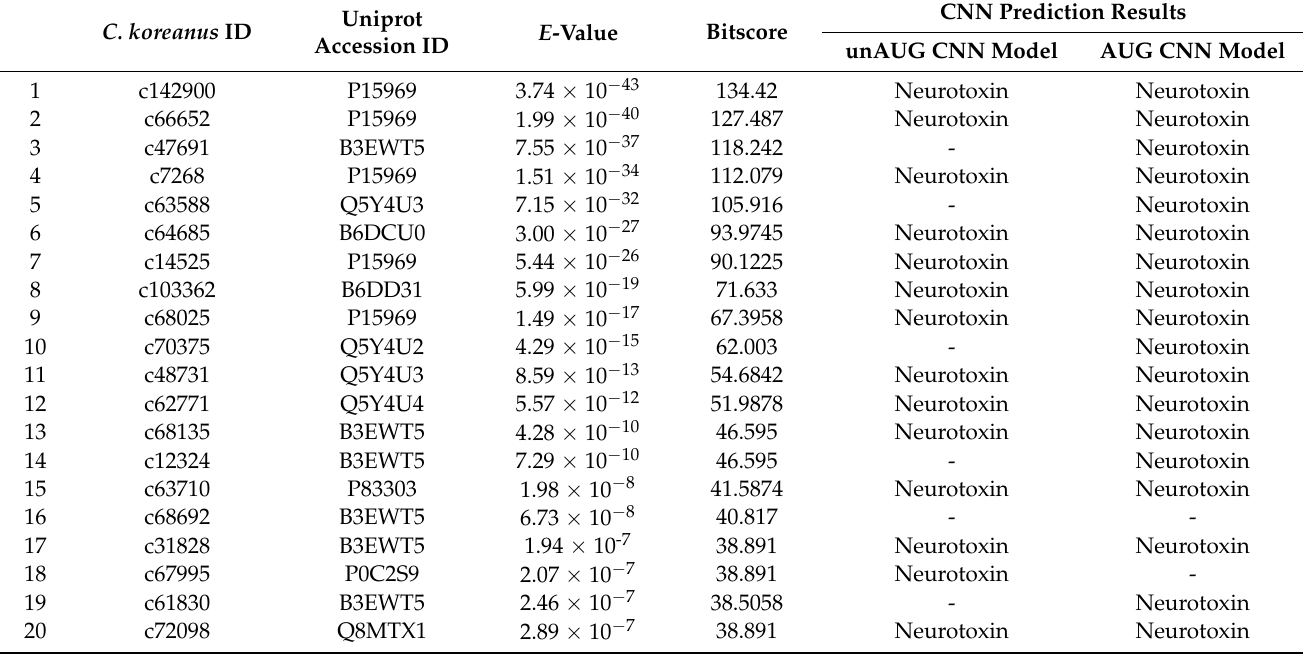
Figure 3. Transcriptome analysis of C. koreanus and comparison of estimation results from the CNN models and the BLAST. ( A ) The annotation results of COG from the body ( left ) and the venom gland ( right ) were shown in pie charts. ( B ) Estimated neurotoxic peptides by the unAUG model ( left ) and the AUG model ( right ) were presented along with the BLAST results. ( C ) The number of the putative neurotoxic peptides predicted from the BLAST search was larger in the AUG model than in the unAUG model. Table 2. The list of peptides estimated from CNN models overlapping with the BLAST result.